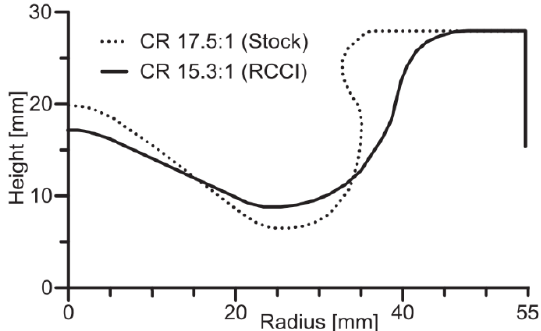
Fig. 15. Differences between piston bowl geometries in different compres- sion ratios for RCCI engine, and classical diesel engine (reproduced from Applied Energy [22] with permission from Elsevier) Fig. 18. Piston bowl geometries and injection configurations in a different fuel supply systems in RCCI engines (reproduced from Applied